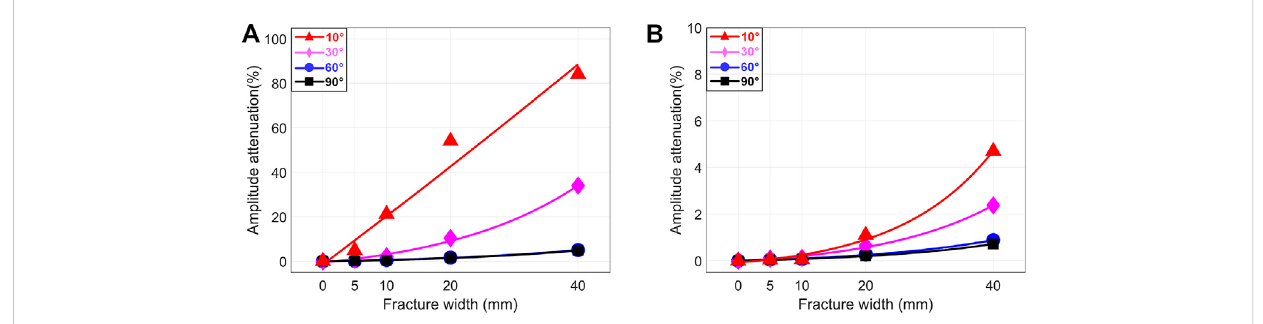
FIGURE 12 AmplitudeattenuationofP-andS-wavesversusdifferentfracturewidthsand dipangles. Thefracture is fi lled withcalcite.The fracturewidthsare 0, 5, 10, 20 and 40 mm. The fracture dip angles are 10 ° , 30 ° , 60 ° and 90 ° . (A) P wave; (B) S wave.